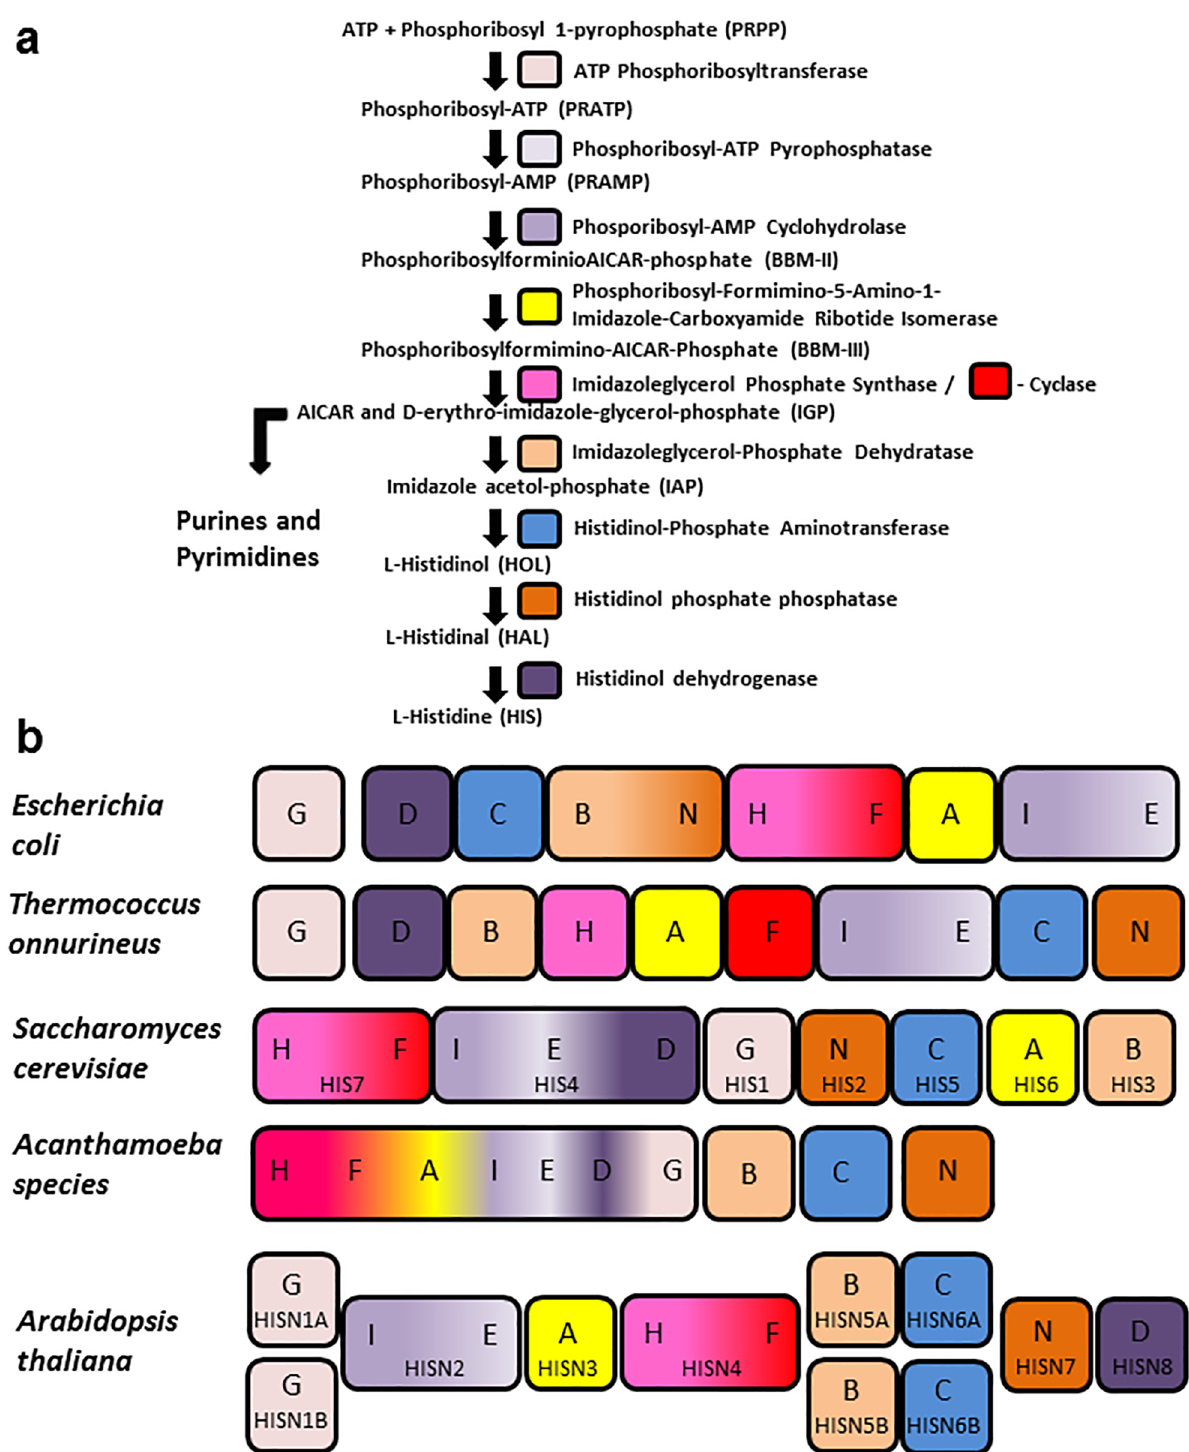
Fig 1. Histidine biosynthesis. Histidine biosynthetic pathway (a). Molecular arrangement of the histidine biosynthesis genes in bacteria ( Escherichia coli ), archaea ( Thermococcus onnurineus ), yeast ( Saccharomyces cerevisiae ), Acanthamoeba species ( Acanthamoeba castellanii ) and plant ( Arabidopsis thaliana ) (b).